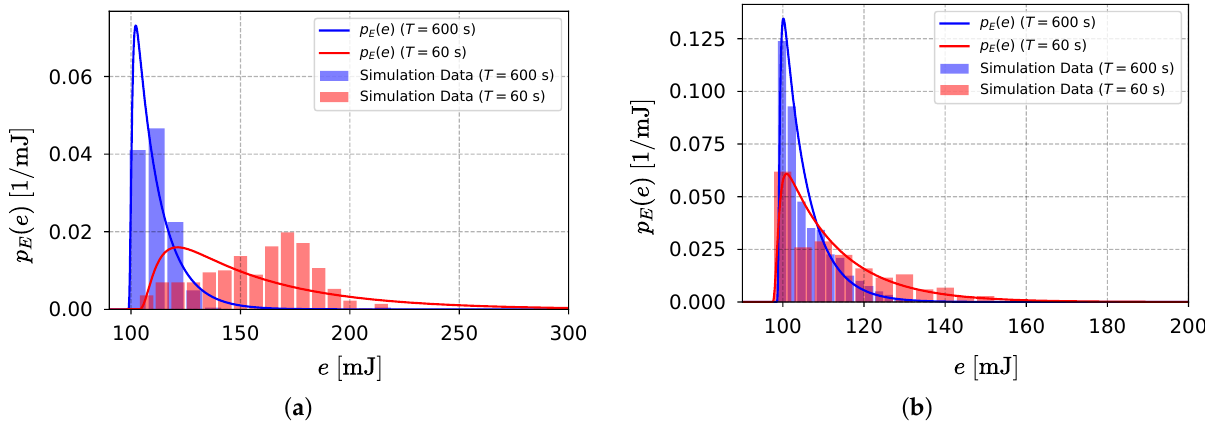
Figure 10. Comparison of the energy performance ( a ) before and ( b ) after the proposed